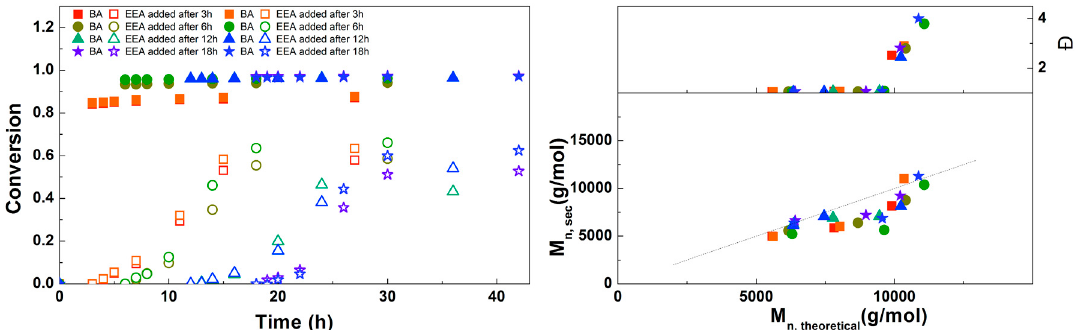
Figure 9. ( Left ): conversion versus time plot for Cu(0)-mediated one-pot block copolymerization of BA and EEA using [BA]:[EEA]:[EBP]:[Me 6 TREN]:[CuBr 2 ] = 50:50:1:0.15:0.1, 3.0 M in DMF at 25 °C and 12.5 mm 2 /mL Cu(0) wire. A 3.0 M solution of EEA in DMF was added after 3, 6, 12 or 18 h reaction time (closed symbols: BA, open symbols: EEA). ( Right ): corresponding molecular weight and dispersity versus theoretical molecular weight plot.